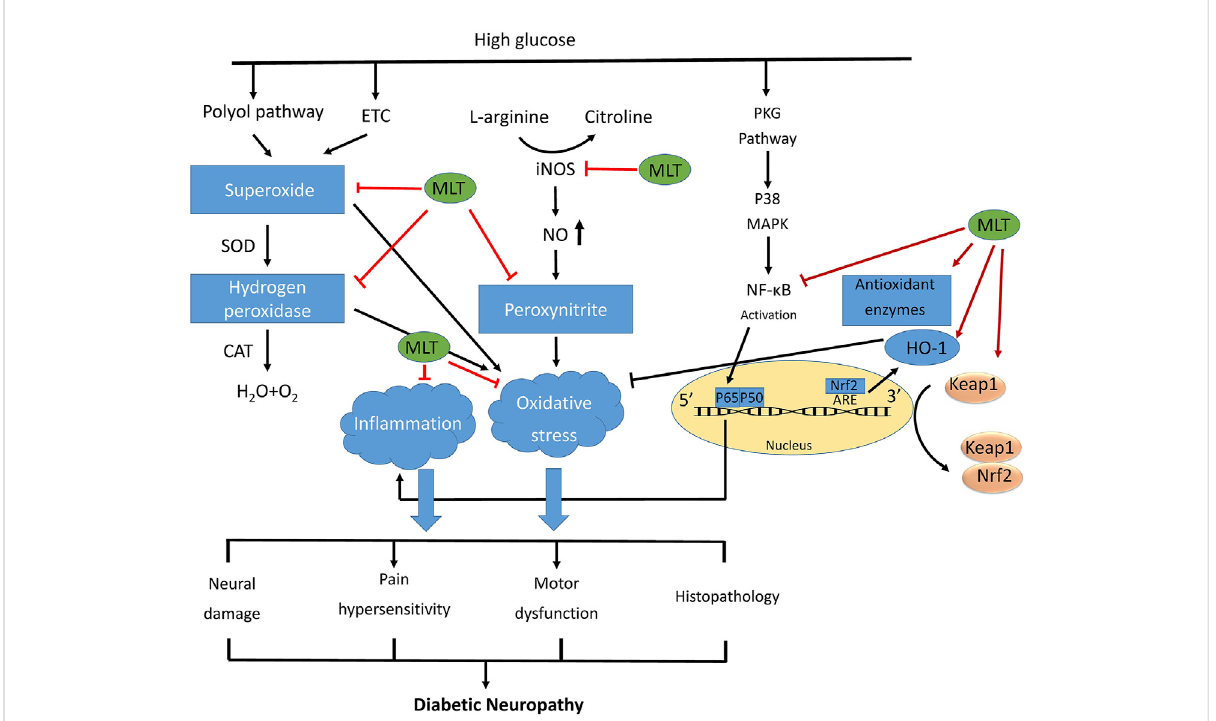
FIGURE 2 The general mechanisms of diabetic nephropathy.Schematic diagram of the protective function of melatonin against diabetic neuropathy by improving oxidative stress and in fl ammatory responses. Hyperglycemia activates many metabolic pathways like polyol pathway, and turnover of the mitochondrial energy-production complexes, leading to release of reactive intermediates. High glucose condition activates also PKC pathway, which lead to NF-kB activation. Melatonin inhibits reactive intermediates and NF-kB, and activates Nrf2, and as well as up regulates proteins expression of antioxidant enzymes, resulting in inhibits the oxidative stress and in fl ammation, and ultimately alleviating the development of diabetic neuropathy. ETC: electron transport chain; PKC: protein kinase